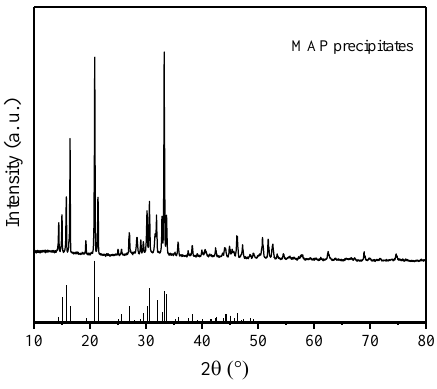
Figure 3. XRD patterns of MAP precipitates. The vertical lines in the figure denote the standard XRD patterns.